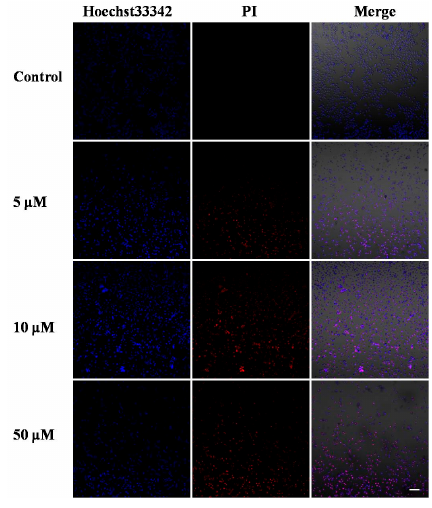
Figure 2. Morphological changes of MCF-7 cells by Hoechst33342 and PI staining treated with 0, 5, 10, and 50 μ M of V 18 . Scale bar: 50 μ M.